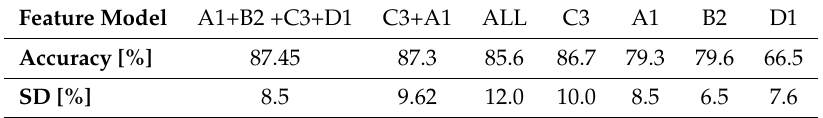
Table 2. Model Performance for second set of participants for different tasks (Selected classifier: LDA). Feature